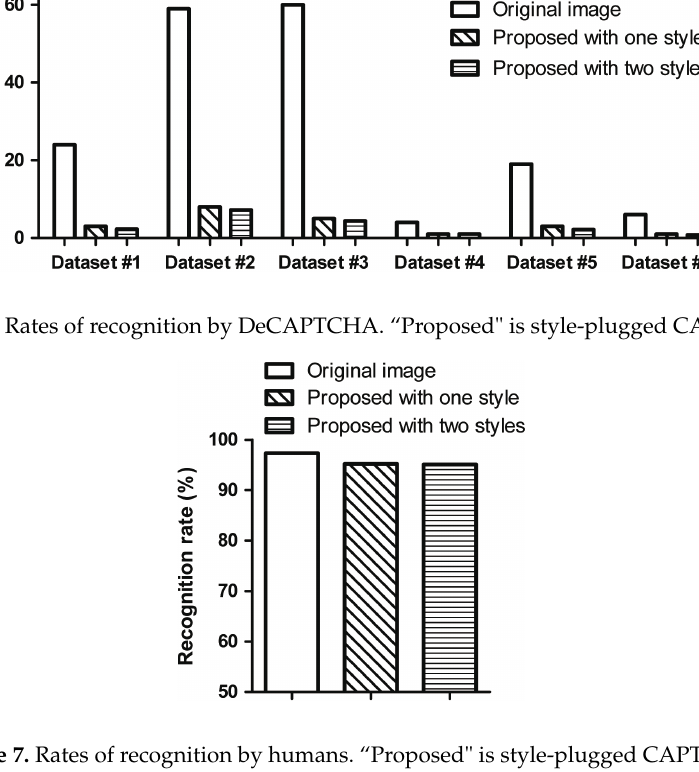
Figure 7. Rates of recognition by humans. “Proposed" is style-plugged